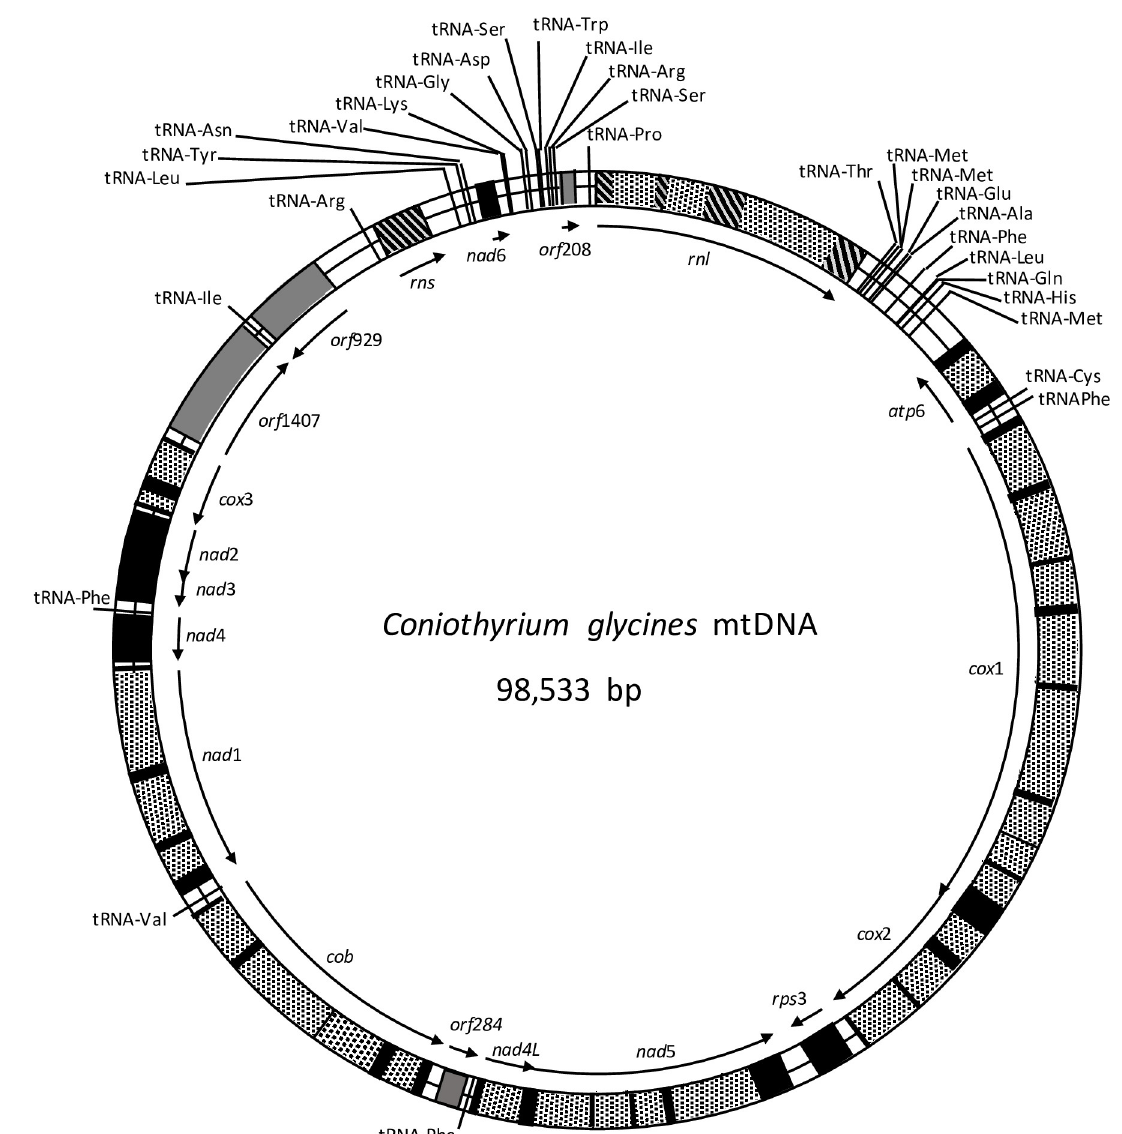
Fig 1. Circular mapping of the mitochondrial genome of Coniothyrium glycines . Black blocks, grey blocks, hatched blocks, stipled blocks, and bars show, respectively, protein-coding, orfs, rRNA, introns, and tRNA genes. Arrows indicate the direction of